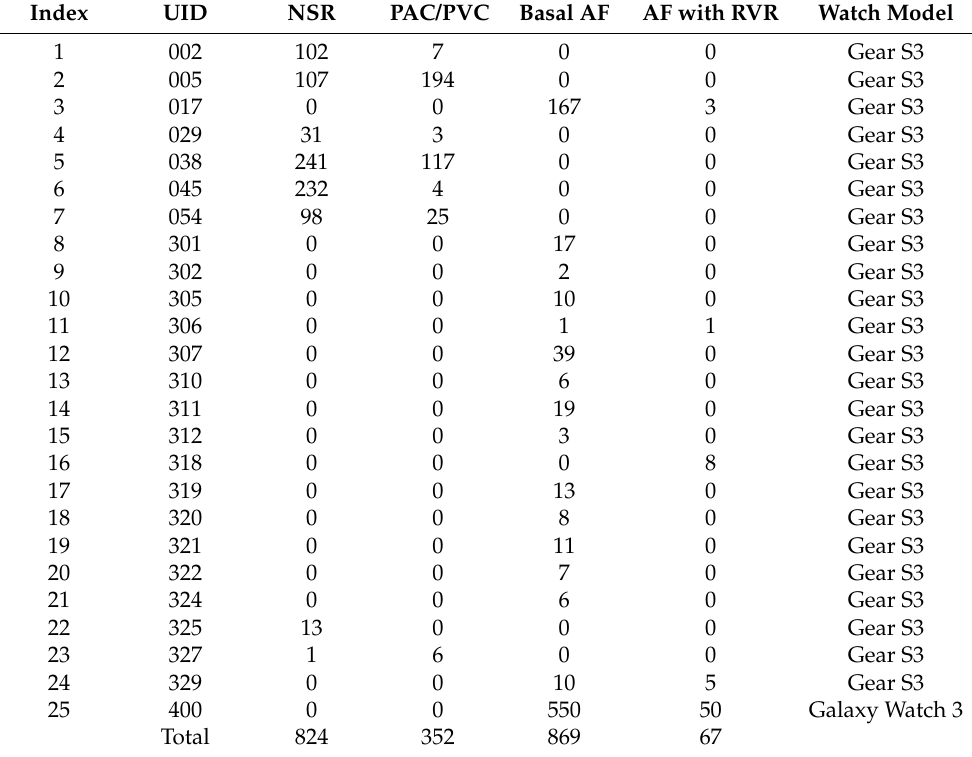
Table A1. Detailed Information of Independent Testing